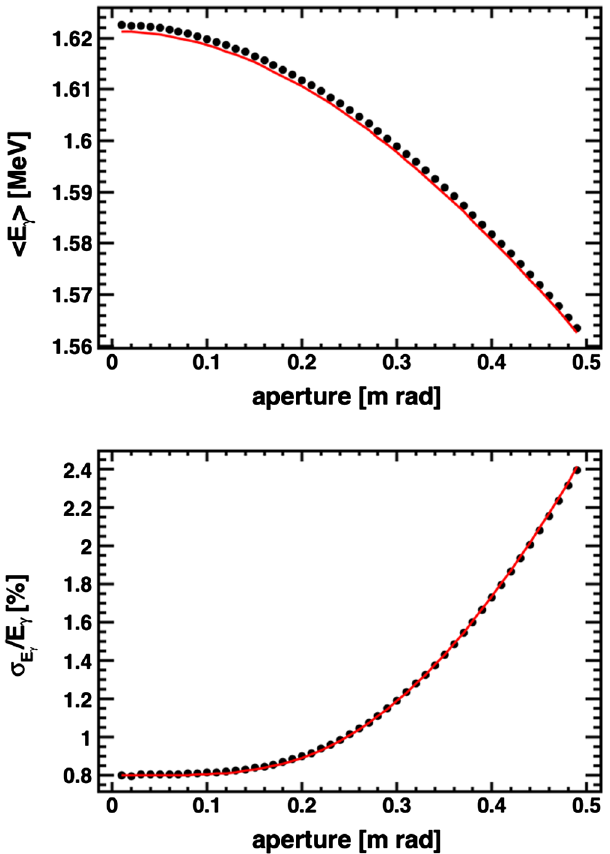
FIG. 2. Average energy (top) and relative bandwidth (bottom) computed using CAIN (black dots) and using the analytical formula (red line) given for plural scattering combined with effect related to electron dressing as a function of the angular aperture. The two curves are superimposed for most values of